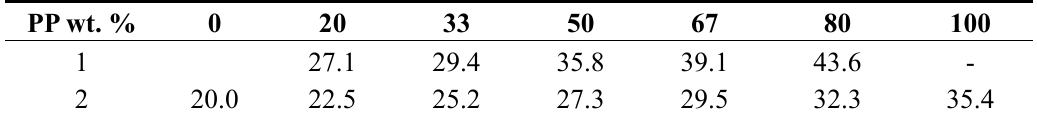
Table 1. Effect of PP on oil